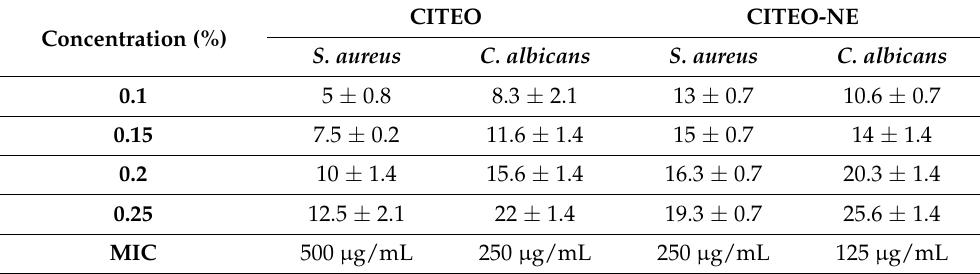
Table 1. Comparative zone of inhibition (means ± SD) and minimum inhibitory concentration (MIC) study of CITEO and CITEO ‐ NE against S. aureus and C. albicans . Concentration